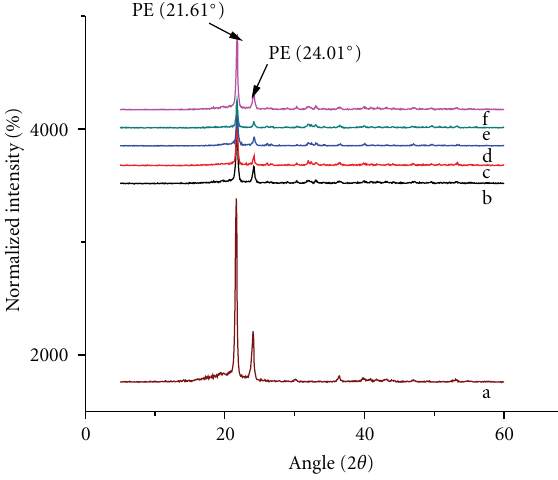
Figure 11: XRD patterns of (a) UHMWPE/HDPE/PEG blend, (b) 10, (c) 20, (d) 30, (e) 40, and (f) 50phr HA content.